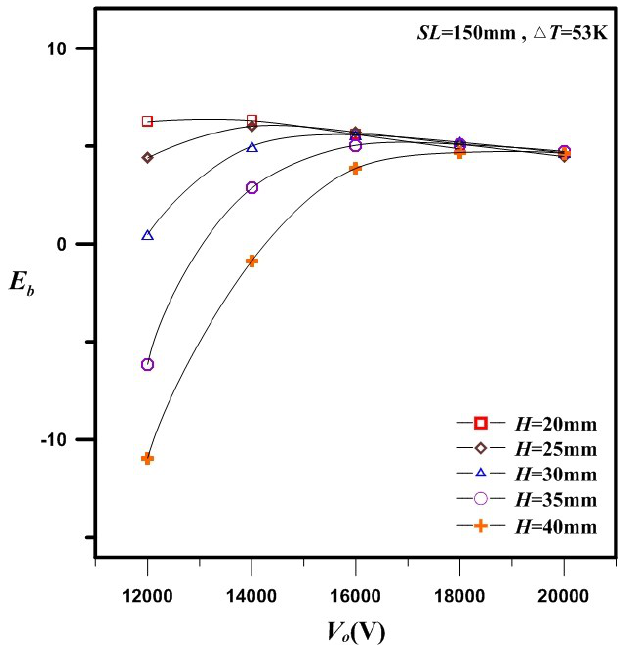
Figure 13. Variations in E b versus applied voltages V 0 for different electrode heights H ( SL = 150 mm and Δ T = 53 K).